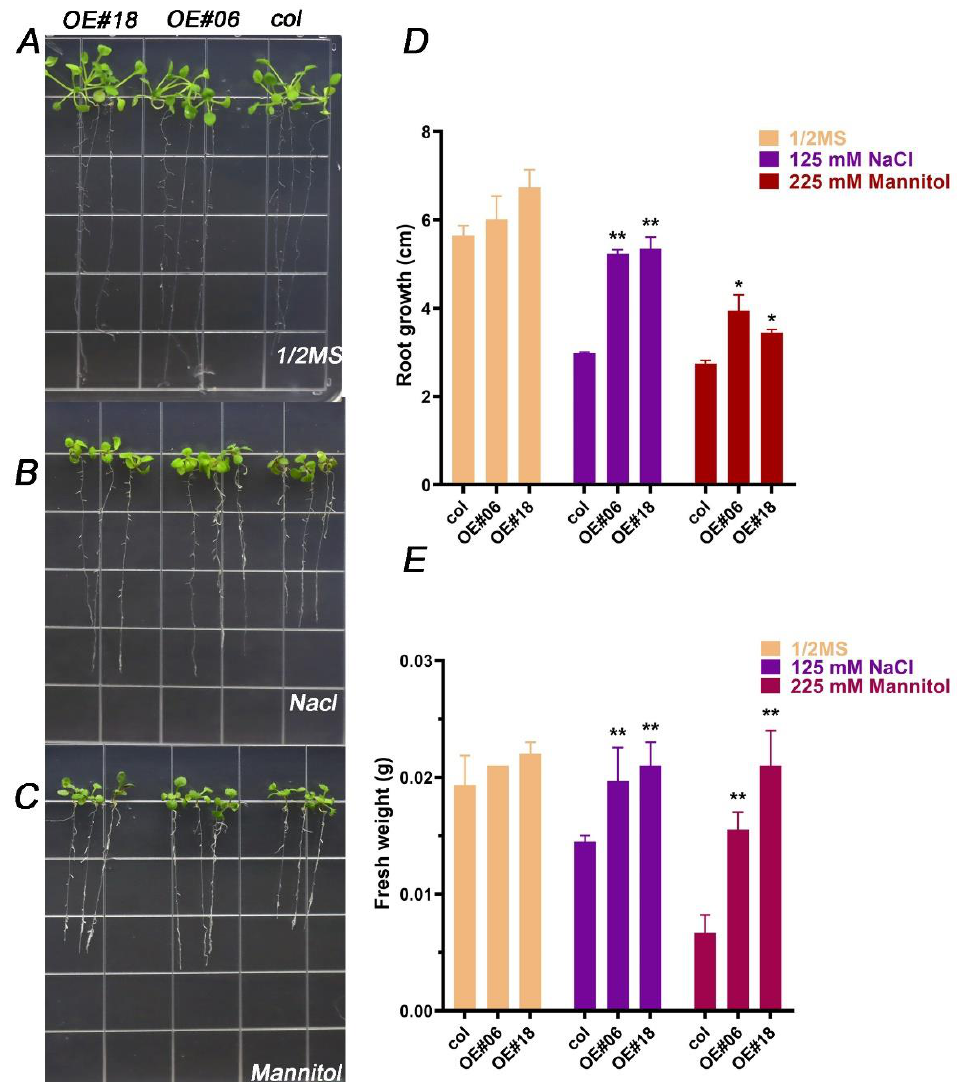
Figure 5. Effects of osmotic stress on the growth of transgenic Arabidopsis seedlings under the condition of half-strength MS ( A ), 125 mM NaCl ( B ), and 225 mM mannitol ( C ), as well as the effects of NaCl and mannitol on root length ( D ) and fresh weight ( E ). The growth of seedlings in half-strength MS medium was used as control. Each value represents three replicate experiments. Values are shown as means ± SD. * p < 0.05; ** p < 0.01 (Student’s t -test).